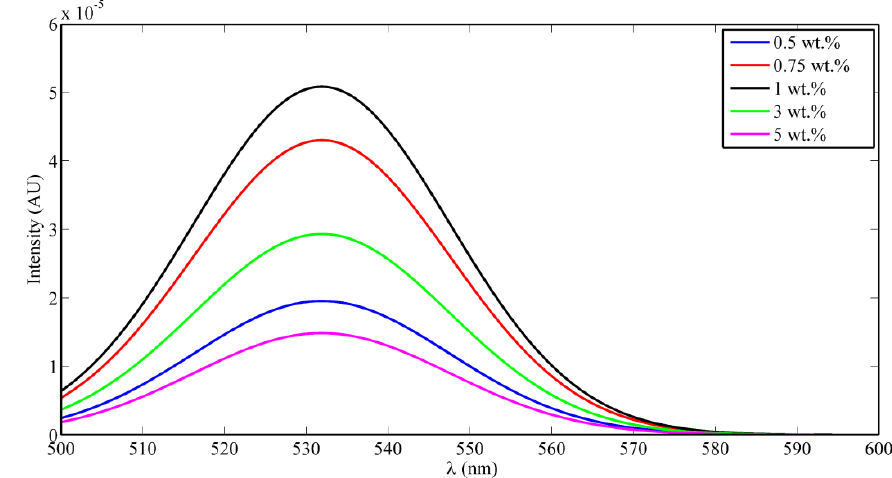
Figure 4. Fluorescence intensity PVA nanofibers (NFs) with in-situ embedded different concentrations ceria NPs.